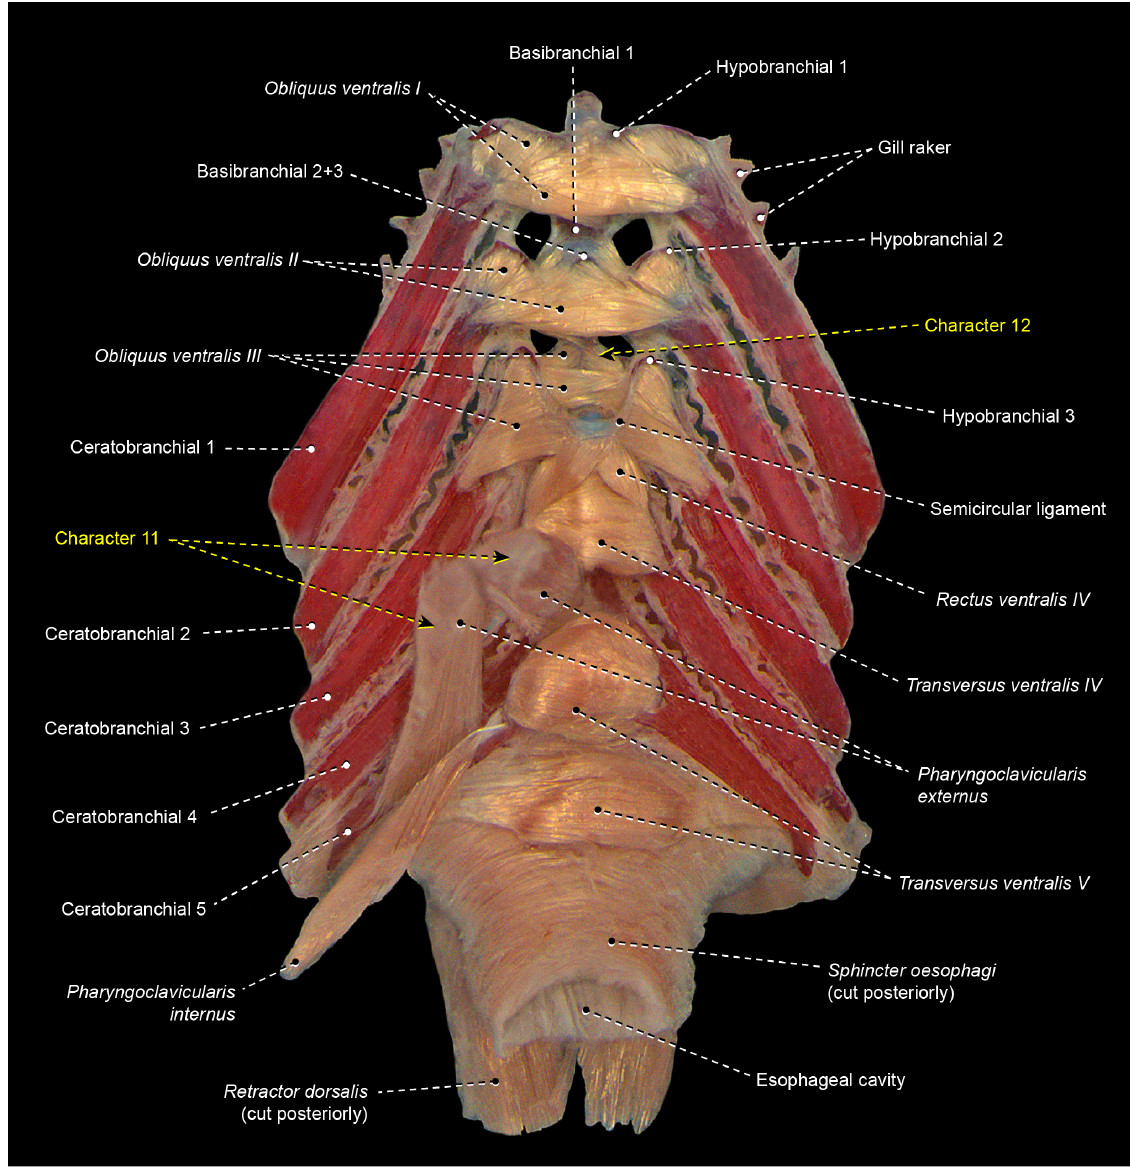
Figure 12. Branchial musculoskeletal system of Fundulusheteroclitus (Cyprinodontiformes: Fundulidae). MZUSP 67017. Ventral view; rectus communis and left pharyngoclaviculares externus and internus removed. 13. In most percomorphs, including Scombrolabrax and Poma-